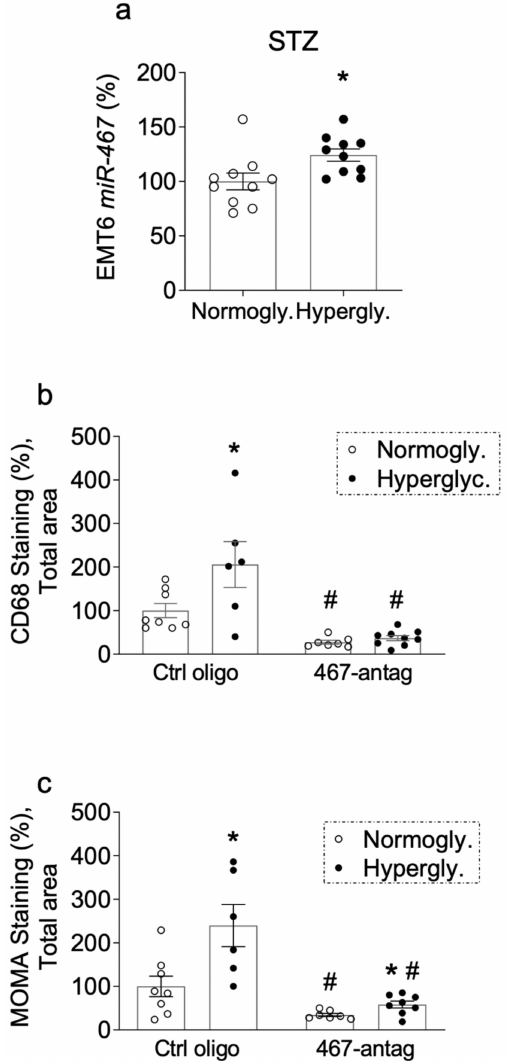
Figure 2. Inhibition of miR-467 with antagonist prevents hyperglycemia-induced macrophage accumulation ( a ) RNA from whole tumors was extracted and miR-467 was assessed ( n = 10/group). ( b , c ) Sections of tumors harvested from hyperglycemic mice (STZ-treated) and normoglycemic mice that received systemic injections of miR-467 antagonist or ( a ) control oligonucleotide were stained with ( b ) anti-Cd68 antibody. ( c ) anti-MOMA-2 antibody. In ( a – c ), an increase over the average levels in normoglycemic mice injected with control oligo is shown, with control average as 100% ( n = 10/group). Scale bars = 10 µ M. Bars represent the mean ± SEM. * p < 0.05 comparing normoglycemic groups, # p < 0.05 comparing to the group receiving the control oligonucleotide (Ctrl